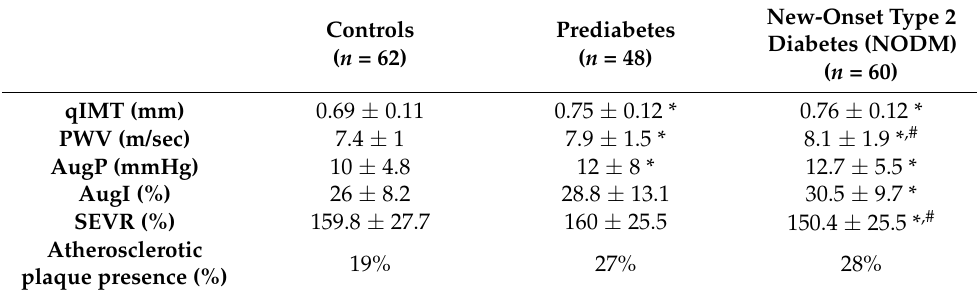
Table 3. Arterial stiffness and thickness parameters according to glucose tolerance.